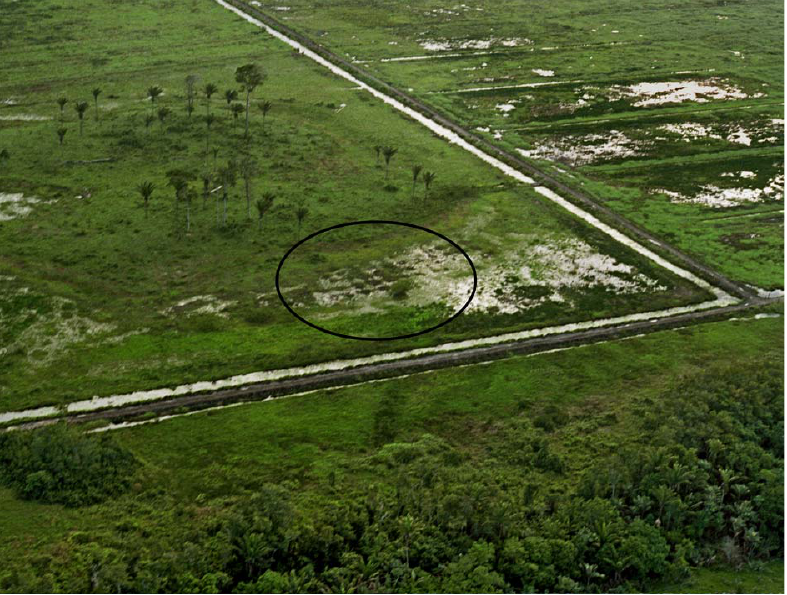
Figure 3. The circled area indicates the remains of a raised field under modern polders near Mana, western French Guiana.